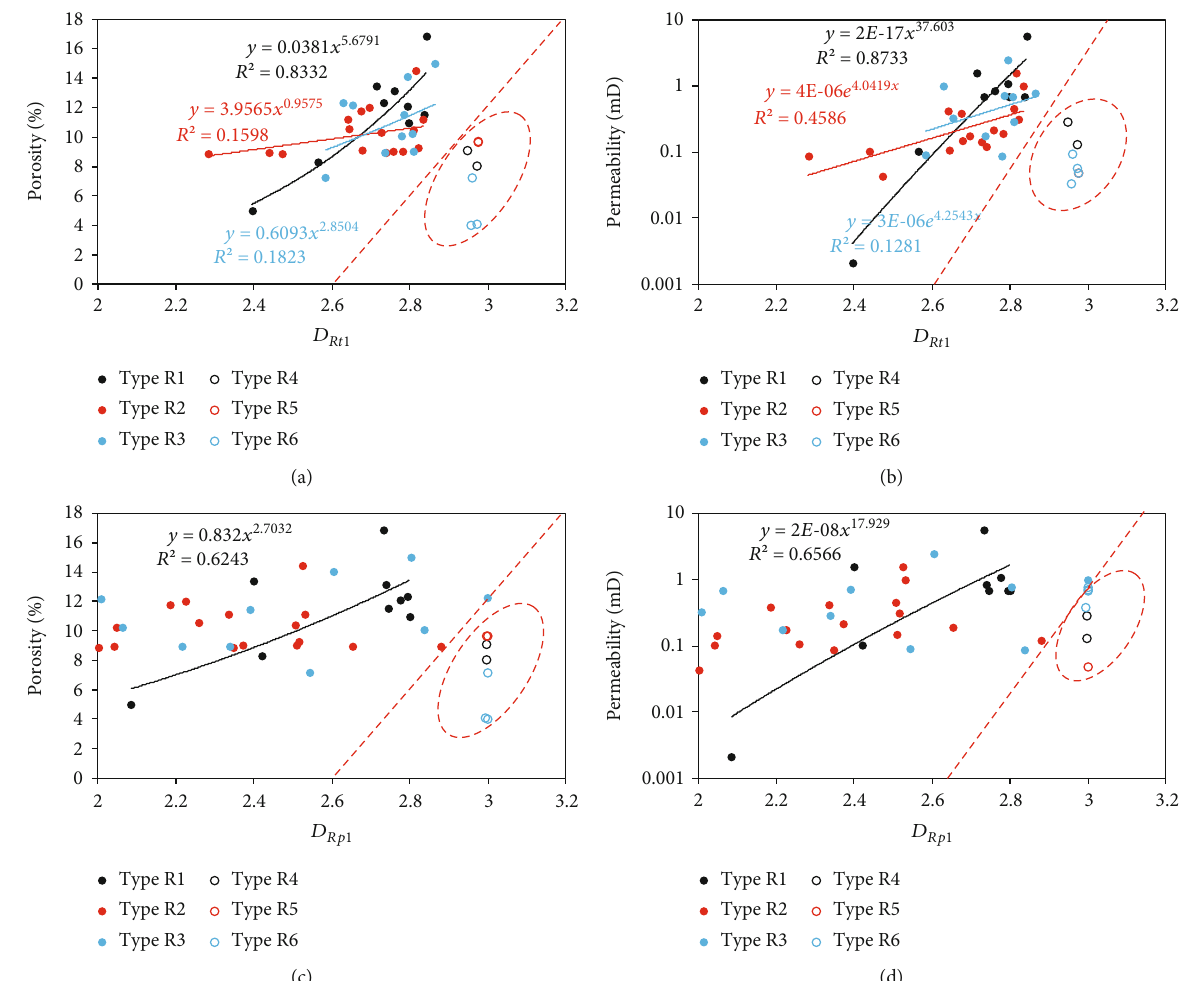
Figure 10: The cross-plots between multifractal parameters from RCMI tests and petrophysical properties: (a) the cross-plots between D and porosity; (b) the cross-plots between D and permeability. D Rp 1